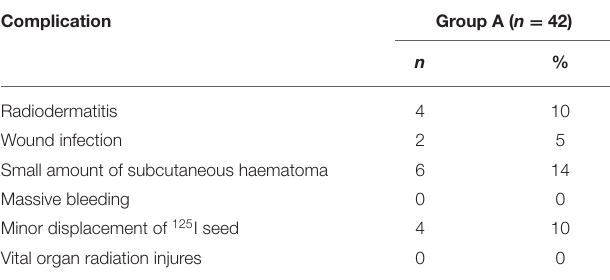
TABLE 5 | 125 I brachytherapy-related